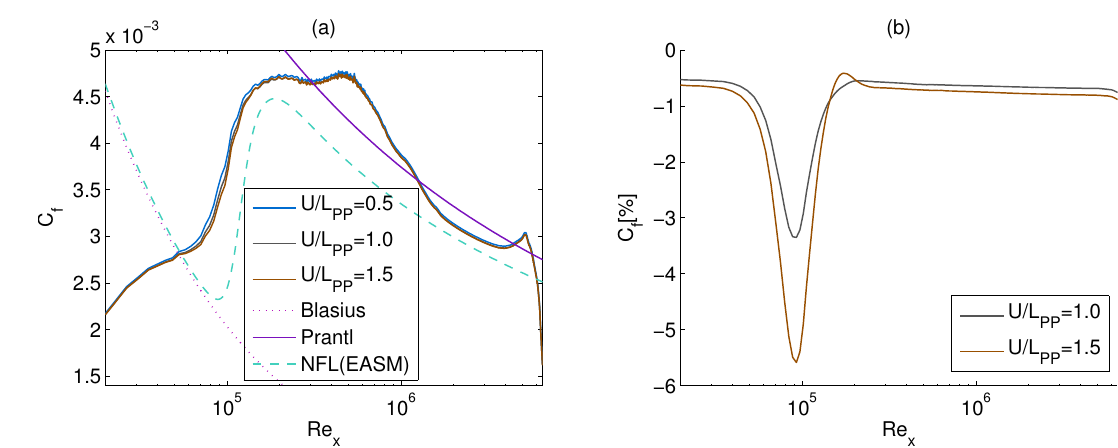
Figure 9. ( a ) Comparison of the local frictional resistance coefficients of H1 hull for the domain size variation in U/L PP and ( b ) comparison of C f of H1 hull relative to U/L PP =